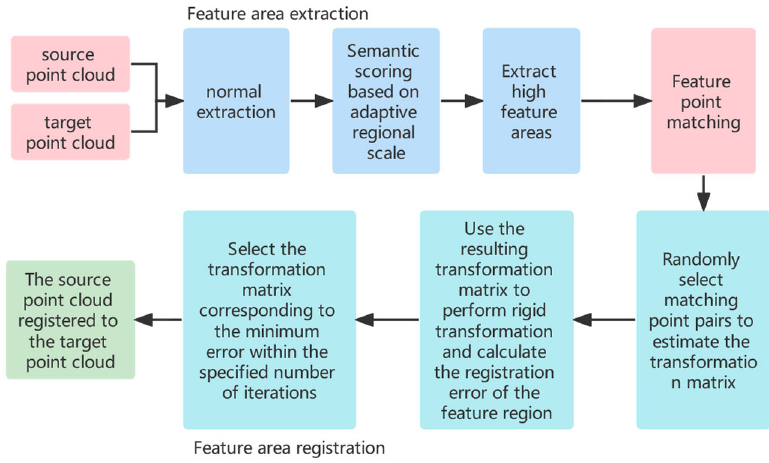
Figure 2. Point cloud registration method based on custom semantic feature extraction.